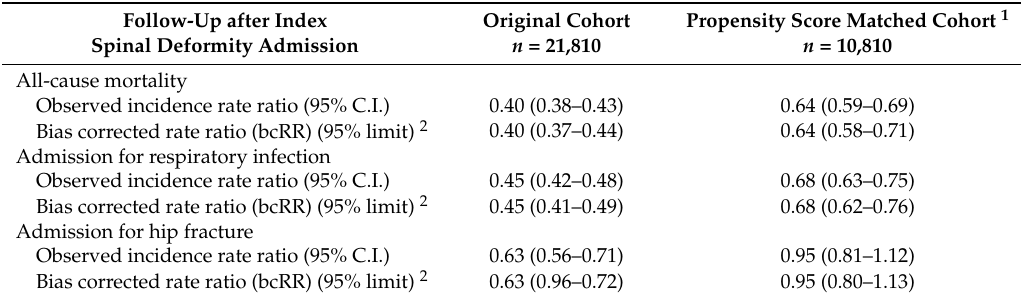
Table 3. Observed incidence rate ratio and bias corrected rate ratio (bcRR) for outcomes after index spinal deformity admission in the original cohort (aged > 50, n = 21,810) and the propensity score matched cohort ( n = 10,810) in Taiwan, 2000–2013.